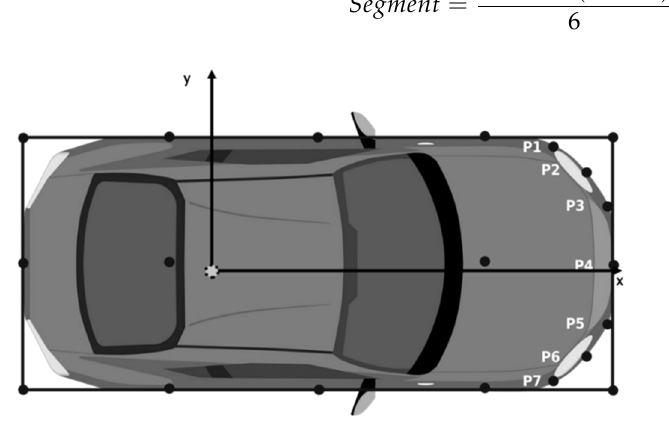
Figure 9. Vehicle schematization.